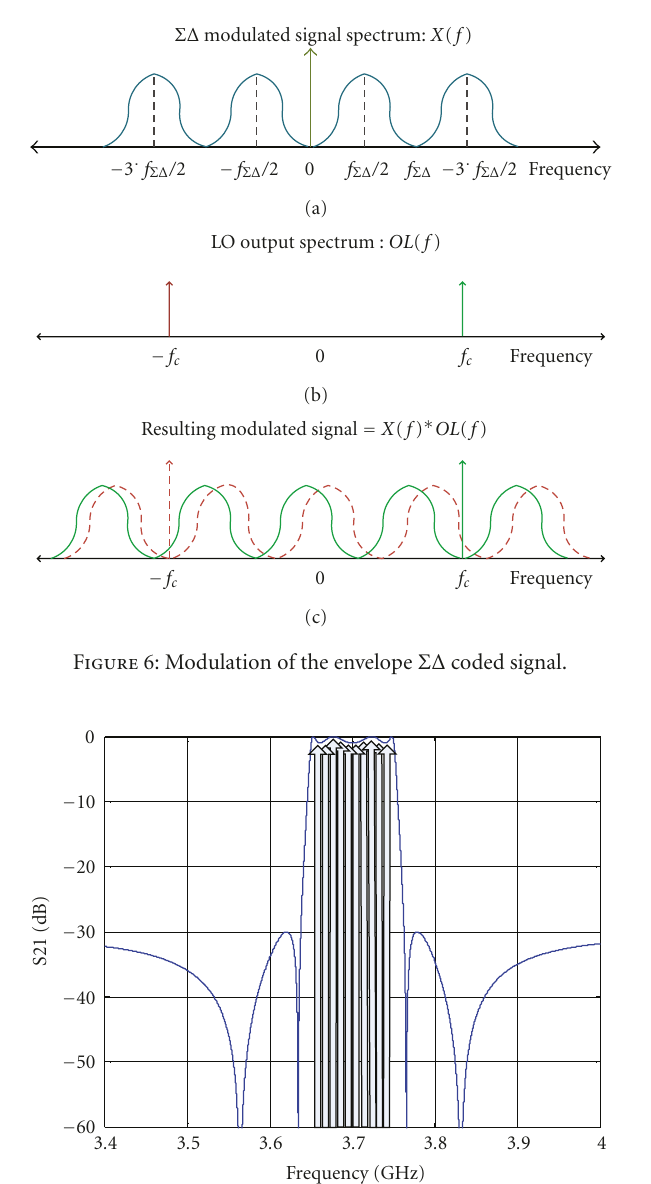
Figure 7: Allocated frequency band and individual